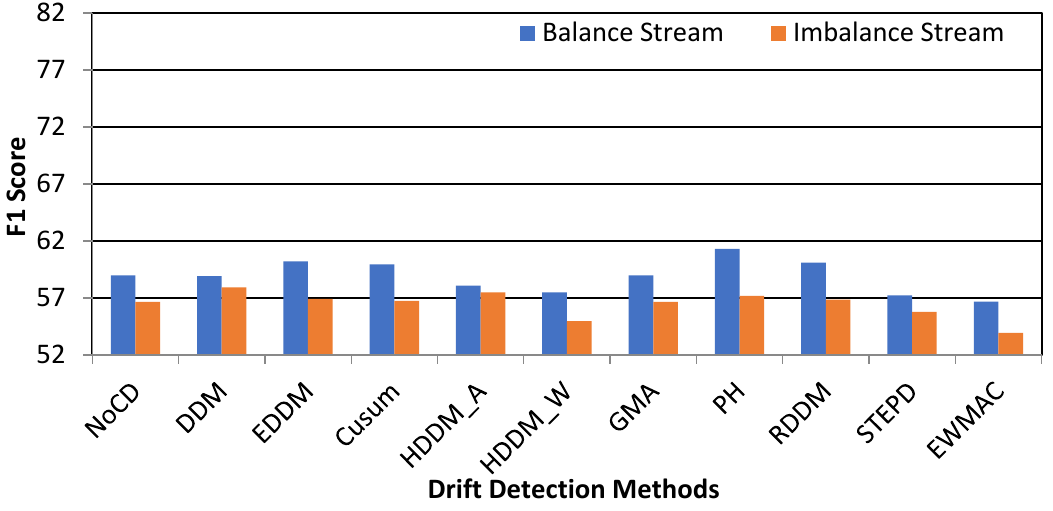
Figure 8. Number of false drifts detected by each method on balanced and imbalanced data streamd. 4.3. Balanced and Imbalanced Data Stream with Incremental Drift An incremental drift takes place when the concept changes gradually with a constant speed, and this is the most difficult drift to detect. The performance of the base classifier on balanced and imbalanced multi-class data streams with increment drift is presented in Figure 9. It can be observed that it is hard to learn from the data steam with incremental drift and the classifier has produced poor results as compared to streams with gradual drift and streams with sudden drift. The class imbalance further decreases the performance compared to the balanced data stream.